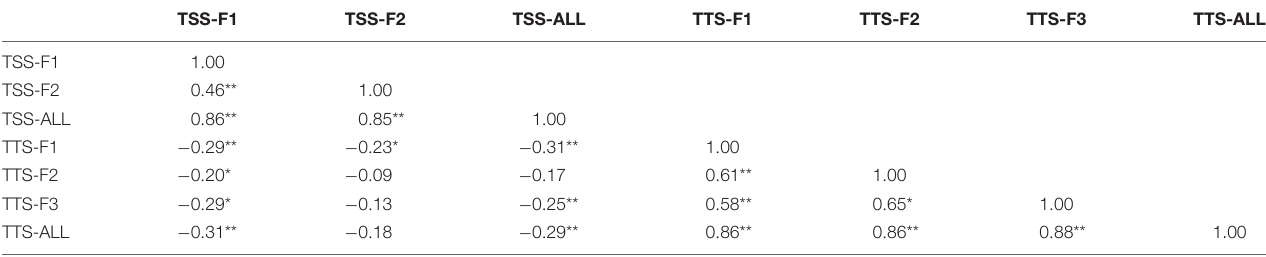
TABLE 10 | Correlations among the TSS and the TTS and their subscales. TSS-F1 TSS-F2 TSS-ALL TTS-F1 TTS-F2 TTS-F3 TTS-ALL